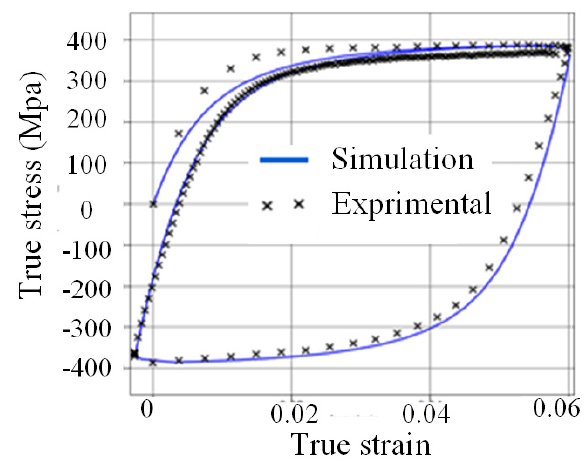
Figure 7. Schematic representation of the material parameter identification process.